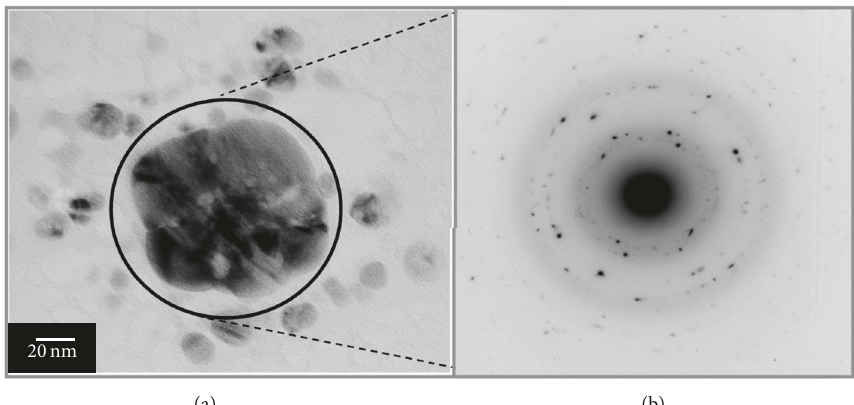
Figure 6: (a) TEM image (scale bar is 20 nm) and (b) corresponding SAED pattern of starch-coated silver nanoparticles after treatment by Hg 2+ solution at a concentration of 500 𝜇 gL −1 in the presence of 0.005 mol L −1 HNO 3 .